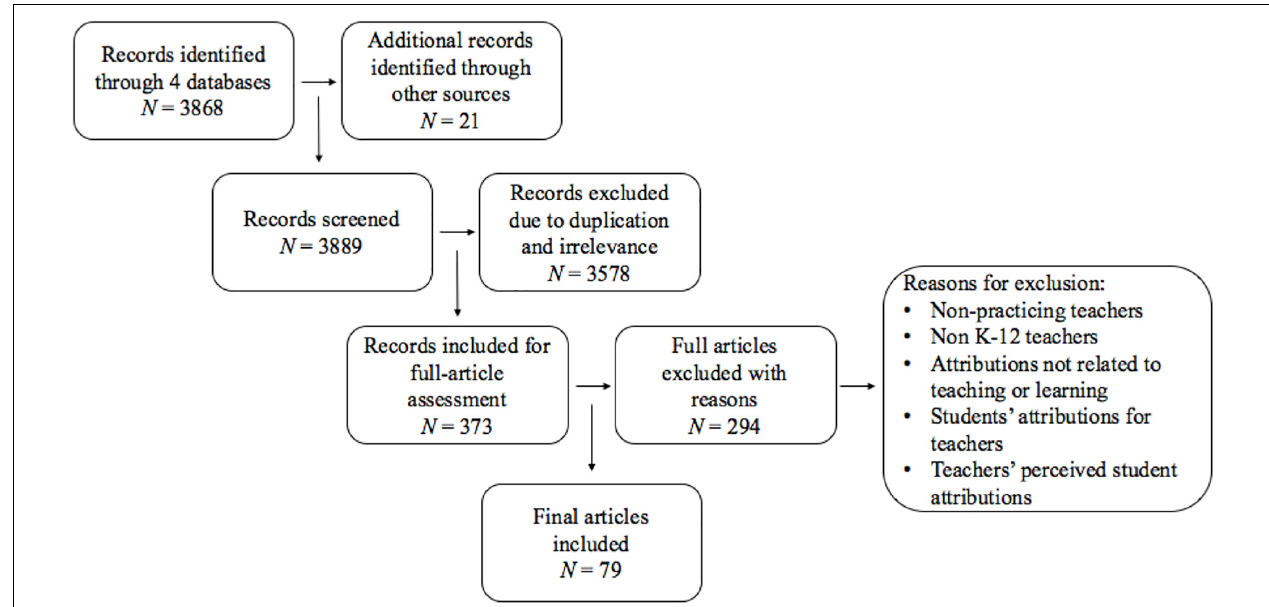
FIGURE 1 | Literature searches flow